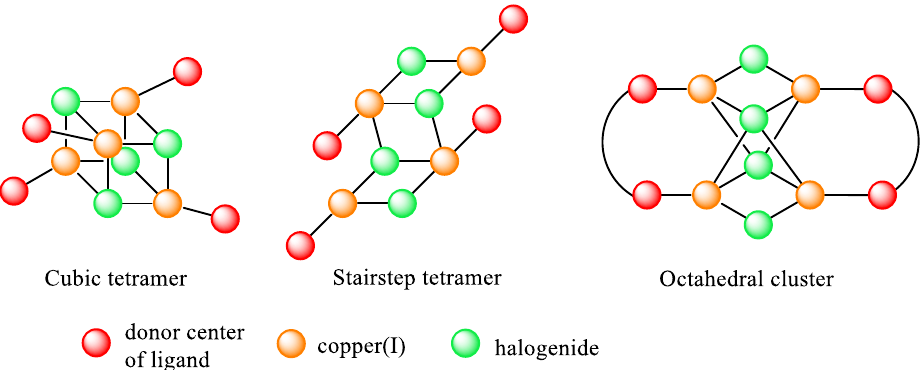
Figure 1. Schematic representation of three types of Cu 4 X 4 clusters.